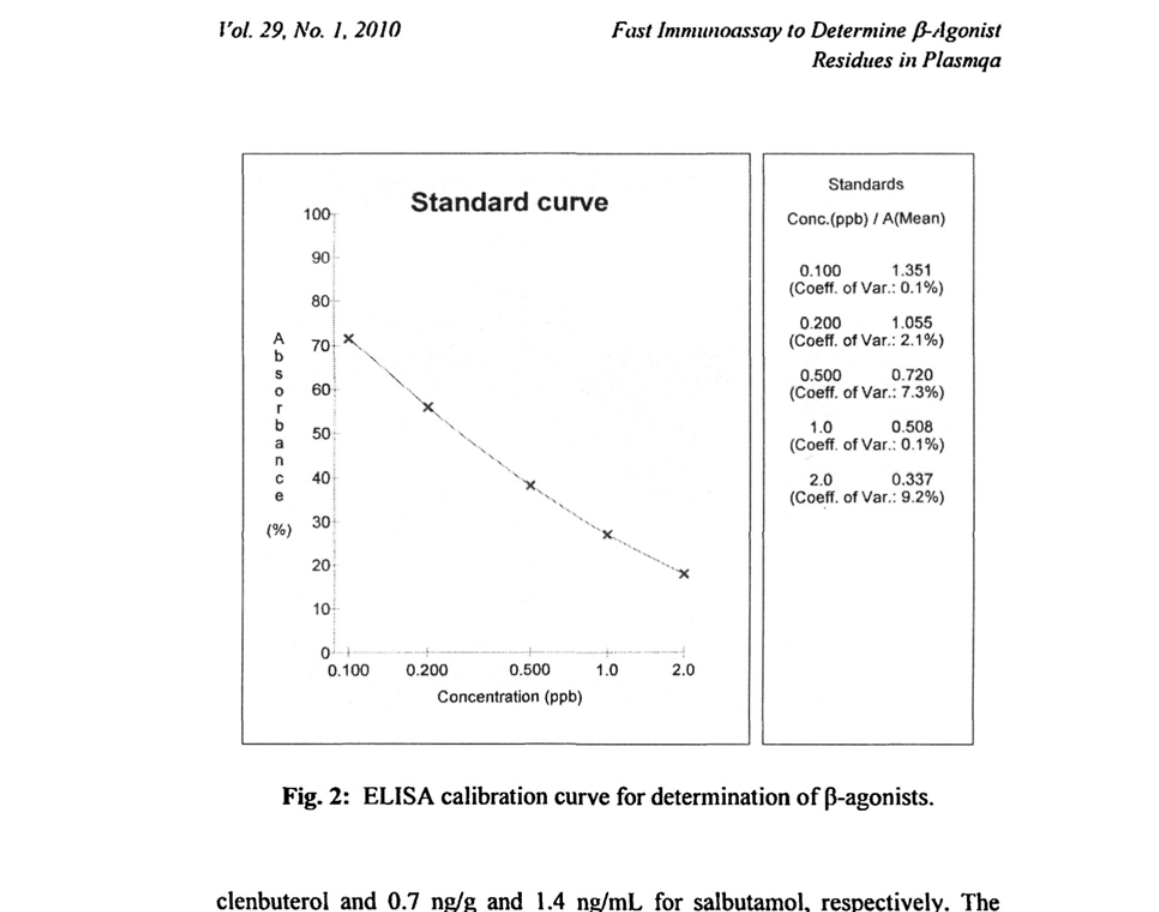
clenbuterol and 0.7 ng/g and 1.4 ng/mL for salbutamol, respectively. The results of method recovery (n=18) and repeatability (n=54) are presented in Tables 1 and 2. Validation of the method used on clenbuterol determination resulted in the mean recovery of 72.6%-81.5% and repeatability of 74.2%- 80.9%, with coefficients of variation (CV) of 3.8%-6.6% and 5.7%-10.6%, respectively. Validation of the method used on salbutamol determination in mouse plasma yielded a recovery of 53.9%-71.4% and repeatability of 55.8%-74.6%, with CV of 6.7%-8.7% and 9.8%-12.8%, respectively. Determination of recovery parameters of both study analytes in plasma samples from both mouse types used as a control group (white BALB/c and black C57BL/6) showed the origin of plasma sampled from either mouse type to have no significant effect (p<0.05) on the level of the analytical method recovery. Validation results demonstrated the method of sample preparation and quantitative determination of ß-agonists by use of ELISA to be efficient in plasma